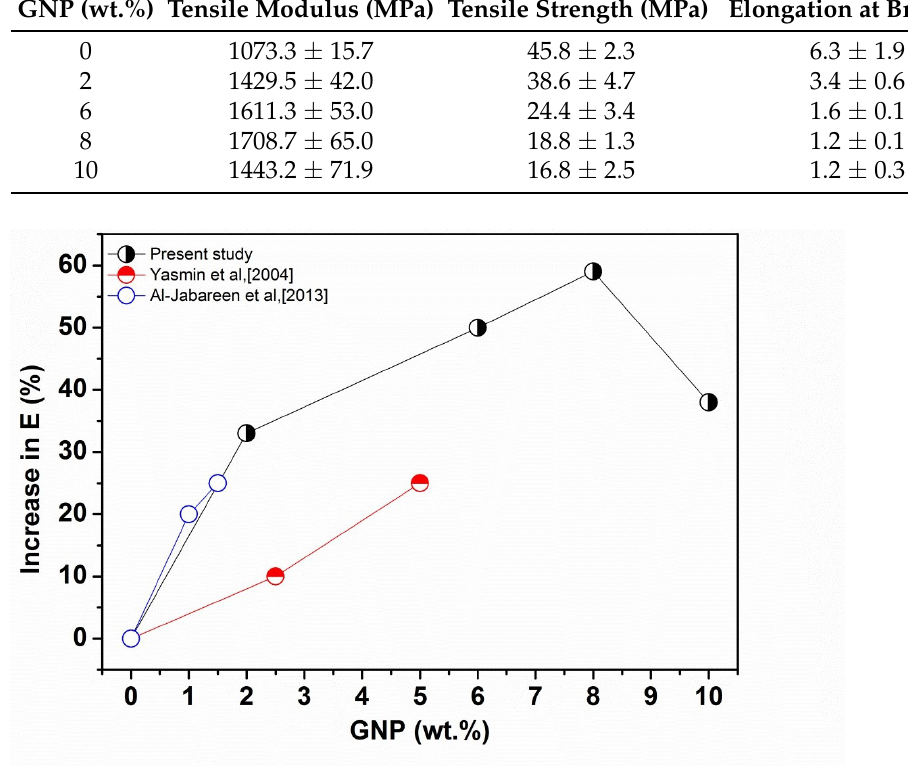
Figure 2. Comparison of the elastic moduli data from Yasmin et al. [31] (Epoxy matrix) and Al- Jabareen et al. [32] (PET matrix) with the present experimental